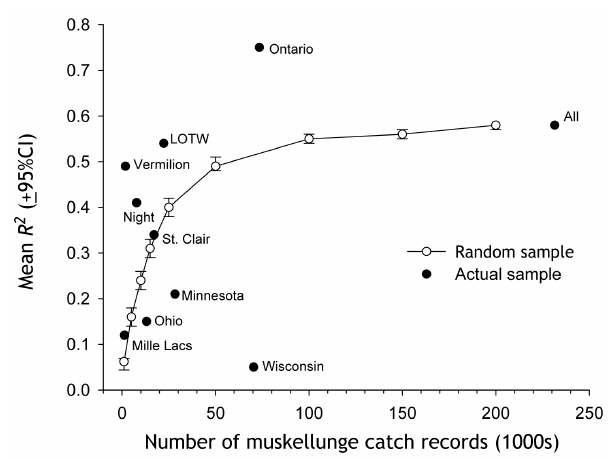
Figure 5. Sample size and the strength of the relationship between the lunar cycle and number of fish caught. For the random samples, R 2 based on models of the form y=a + xcosine2 h , where y = number of fish caught and h is the angular equivalent of lunar day. Actual model R 2 values are from Table 1. LOTW = Lake of the